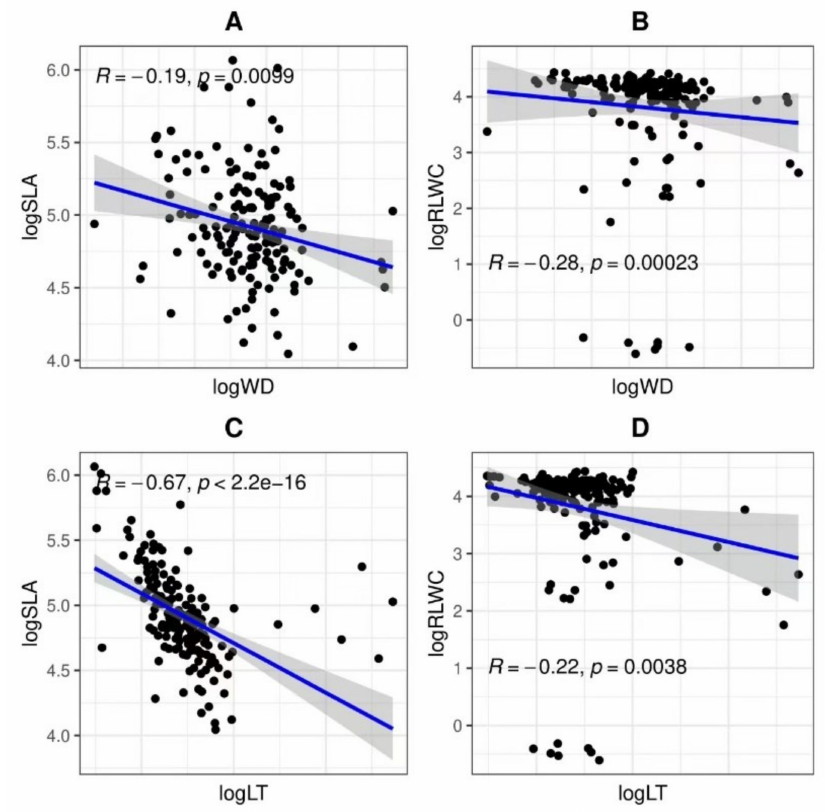
Figure 4. The bivariate association of morphological features of woody species’ aboveground vege- tative parts in tropical coastal secondary forest. Showed the relationship between ( A ) logWD and logSLA, ( B ) logRLWC and logWD, ( C ) logSLA and logLT, and ( D ) logRLWC and logLT. SLA (specific leaf area), WD (wood density), LT (leaf thickness), and RLWC (relative leaf water content) show a significant relationship at the levels of p < 0.05 and p < 0.01